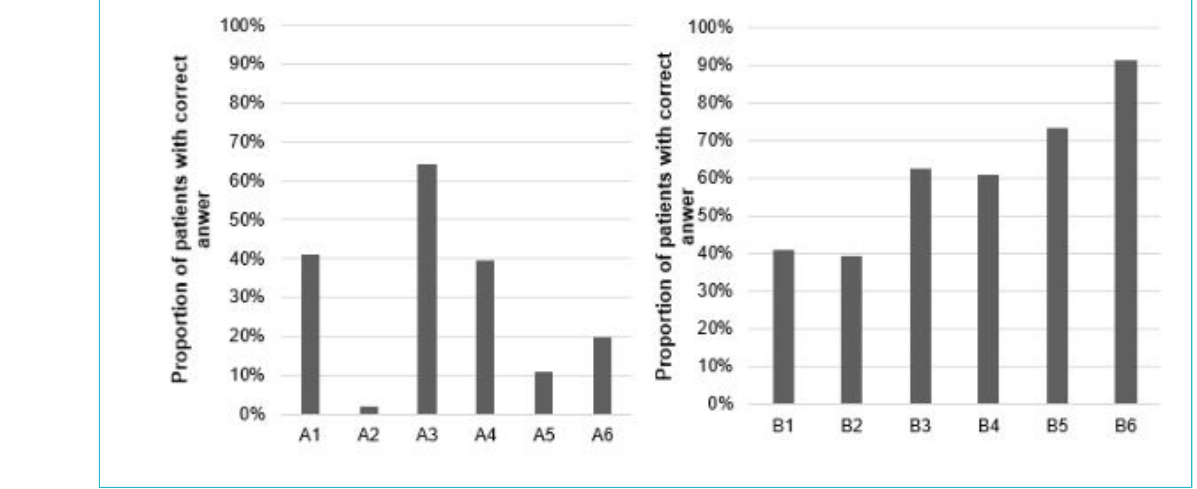
Figure 3: (a: left) Right answers (in %) to the questions of test A, shown in “Material and methods” and in table 1. (b: right) Right answers (in %) to the questions of test B, shown in “Material and methods” and in table